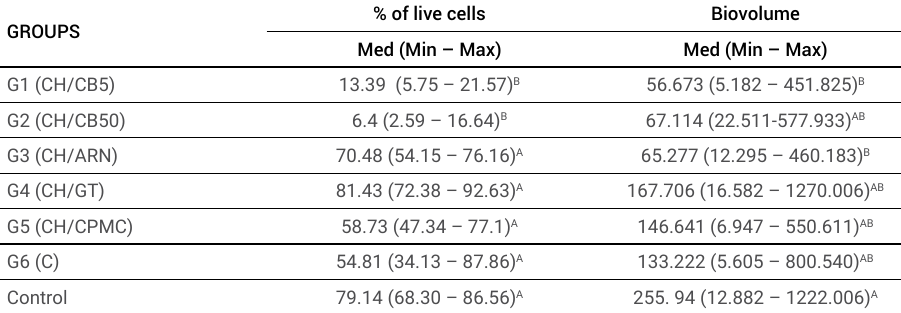
Table 4. Median (Med), minimum and maximum (Min - Max) values of the percentage of live cells and biovolume of the biofilm after the contact with the experimental pastes for 7 days.